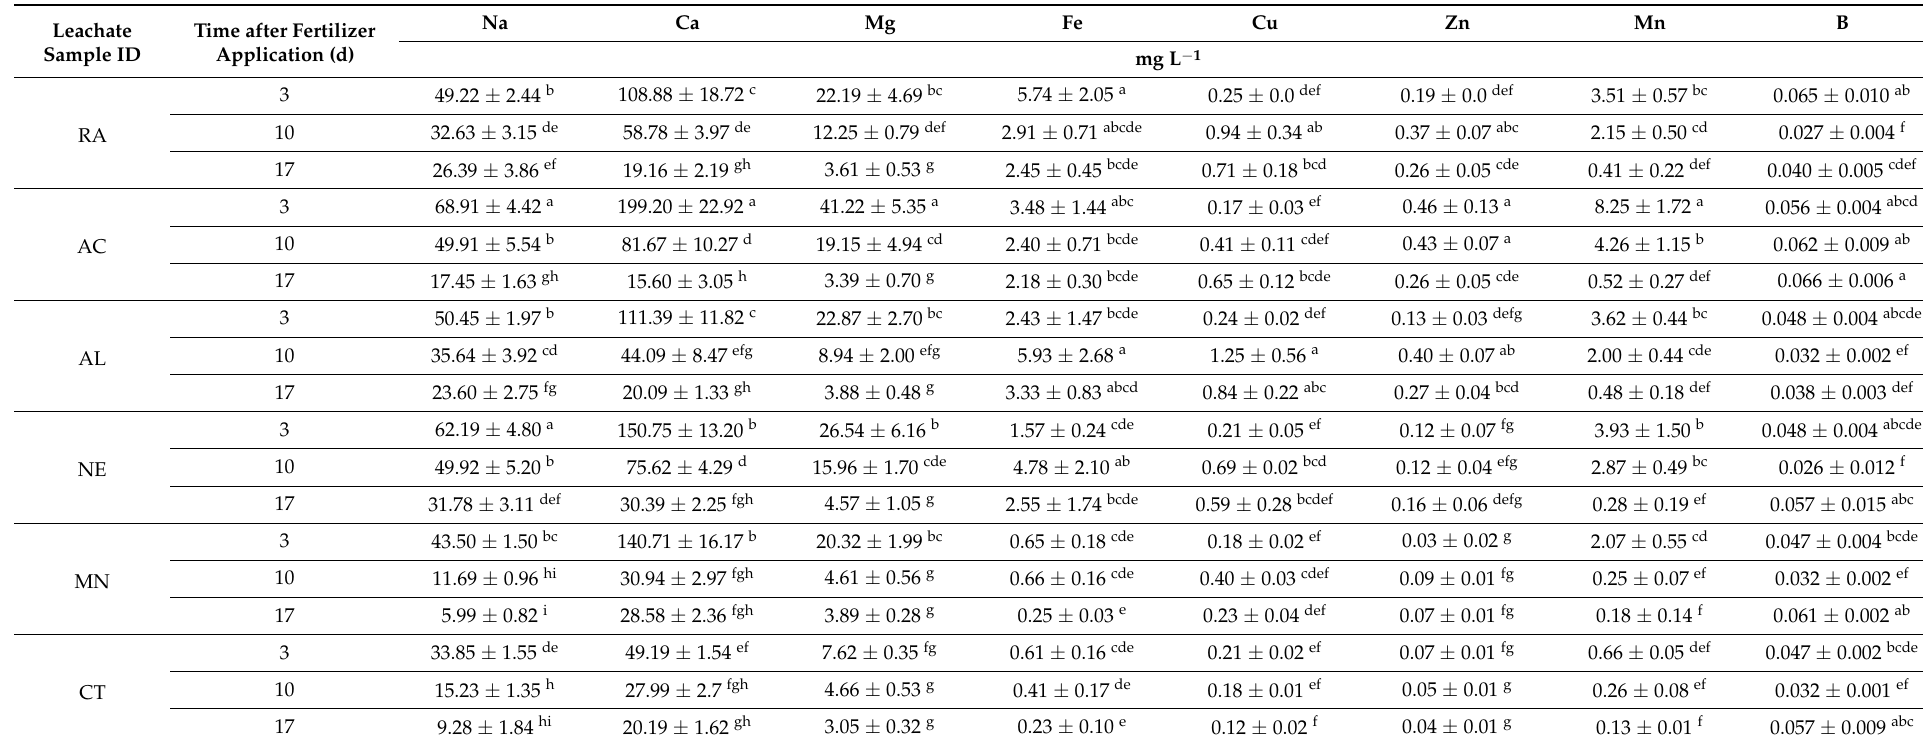
Table 4. Concentration (mg L − 1 ) of Na, Ca, Mg, Fe, Cu, Zn, Mn and B in the leachates collected after the three IEs (corresponding to t = 3 d, t = 10 d, and t = 17 d after fertilizer application, respectively) for each treatment considered (RA = Raw dairy slurry; AC = Acidified dairy slurry; AL = Alkalinized dairy slurry; NE = Neutralized dairy slurry; MN = Mineral fertilizer; CT: Control) (mean value, n = 3). Different letters indicate significant differences based on the Tukey test ( p <